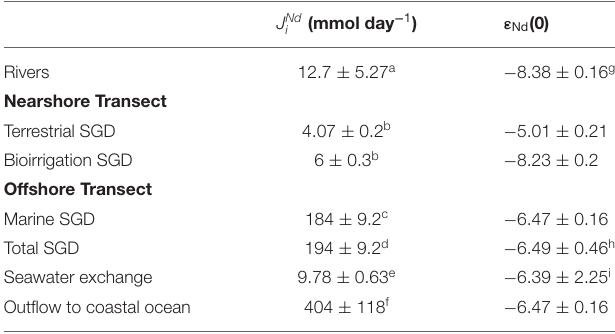
TABLE 5 | Estimates of neodymium fluxes ( J Nd i ) of groundwaters and surface waters of the studied portion of the Indian River Lagoon in mmol day − 1